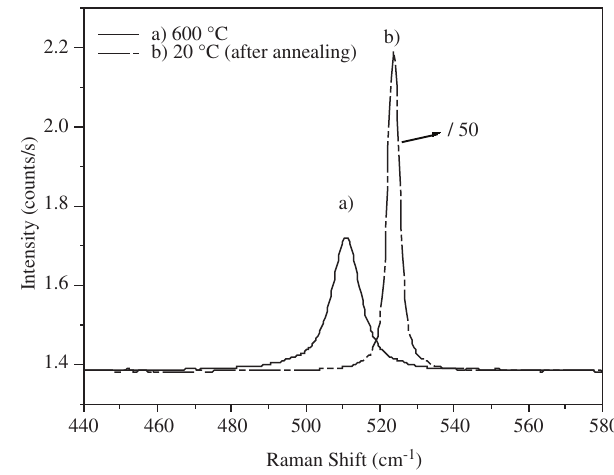
Annealing Temperature